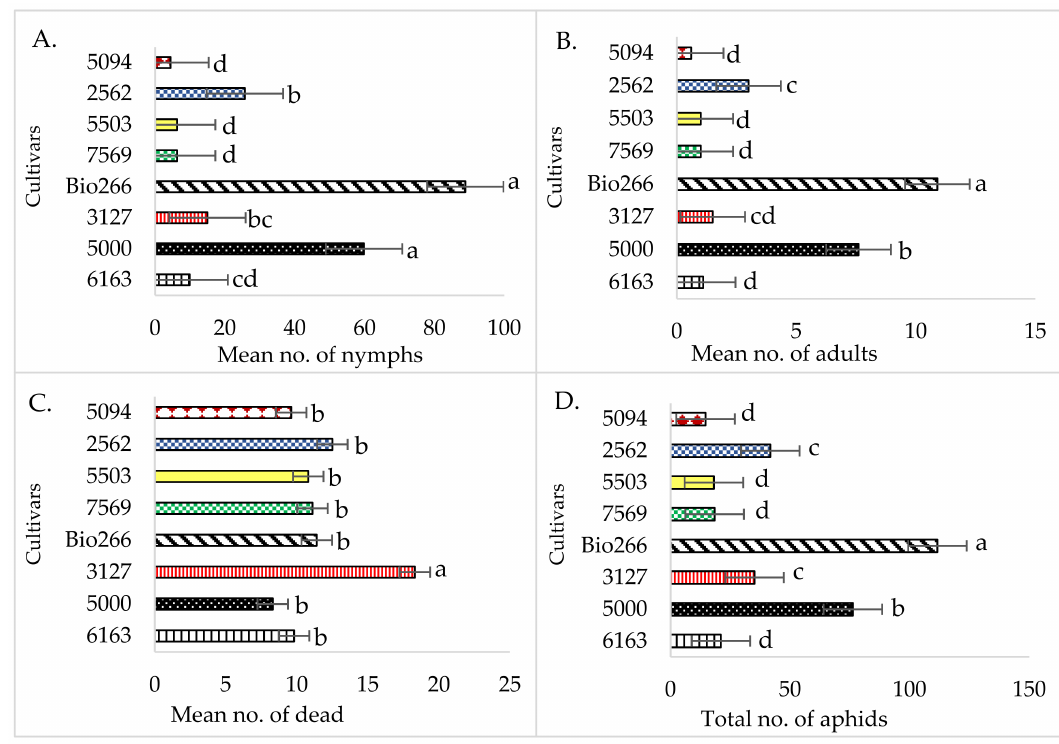
Figure 1. Effect of sugarcane cultivars infected with ScYLV on the biological performance of M. sacchari . Mean ± SE that share the same letter for each parameter are not significantly different ( p > 0.05). Statistical com-parisons between treatments for each parameter were done using the non-parametric Kruskal–Wallis test or parametric ANOVA/Fisher test ( A – D ).